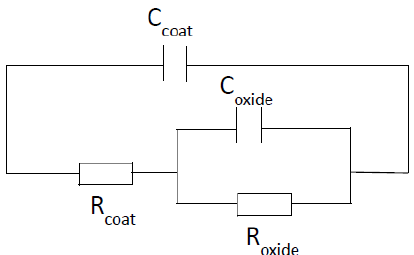
Table 4. Common methods for corrosion